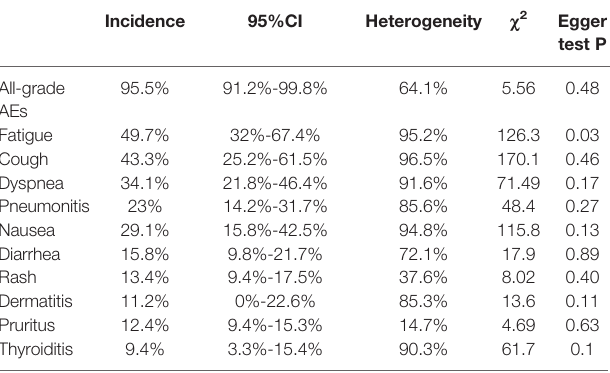
Table 3 represents the incidence of high-grade (grade ≥ 3) AEs in patients treated with ICIs and TRT. The funnel plots of high- grade AEs and pneumonitis were shown in Supplementary Figure 1 . The Egger ’ s test indicated the publication bias of high-grade fatigue, dyspnea, pneumonitis, nausea, colitis, and rash, and “ trim-and- fi ll ” analysis was conducted to address the bias and calculate the pooled incidence. The incidence of high- grade AEs among all patients was 30.2% (95% CI: 18.2 – 42.1%). Pneumonitis was the most common high-grade AE (3.8%, 95% CI: 2.0 – 6.9%), followed by dyspnea (2.1%) and colitis (0.5%). Besides, the incidence of high-grade fatigue, cough, nausea and colitis was 0.3%, 0.3%, 0.1% and 0.5%, respectively. Notably, the incidence of grade 5 AEs was 1.5% (95% CI: 0 – 3.1%), and pneumonitis also exhibited the highest incidence (0.6%, 95% CI: 0.1 –